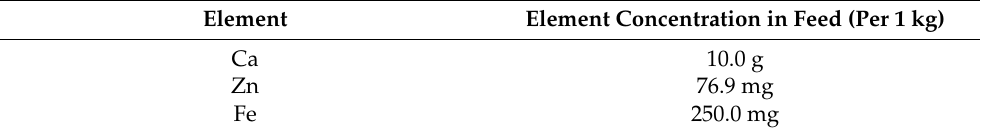
Table 1. Mineral content in Labofeed H feed.